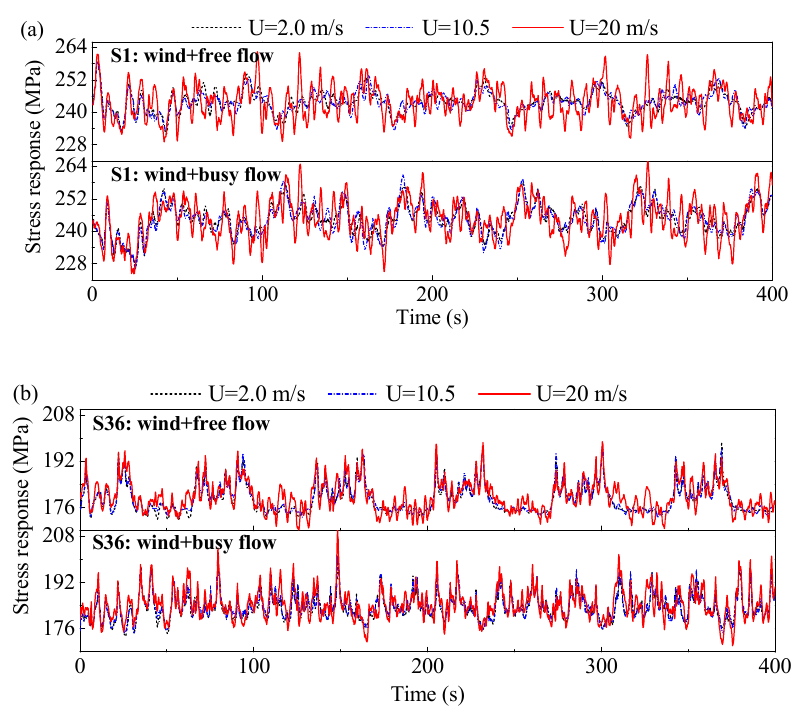
Figure 10. Segment of stress response time histories of representative suspenders under combined wind and traffic load ( a ) suspender S1 and ( b ) suspender S36.